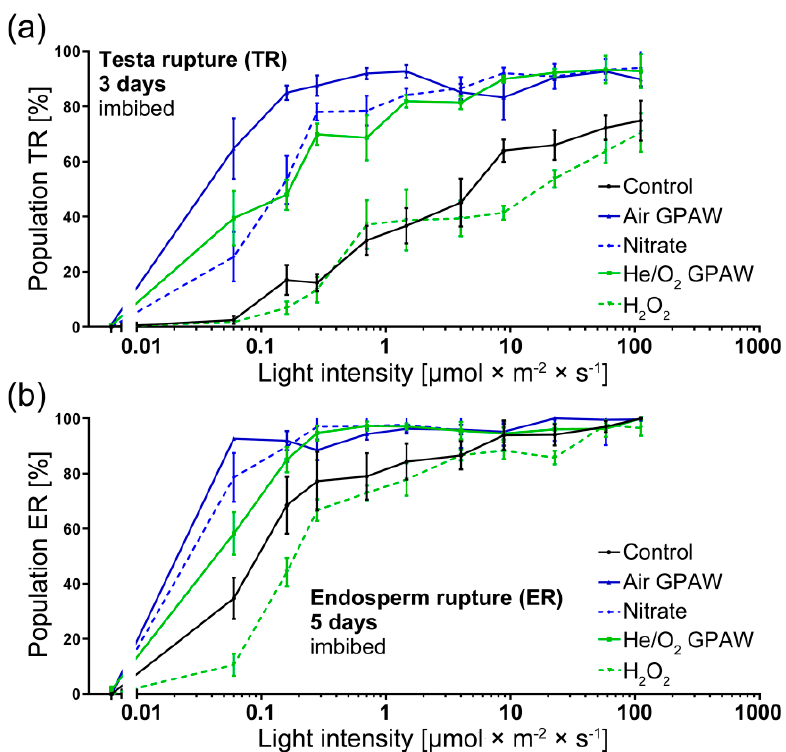
Figure 4. Nicotiana tabacum seed germination under various continuous white-light regimes with and without treatments. ( a ) TR (3 days imbibition) and ( b ) ER (5 days imbibition) percentage of dormant N. tabacum in relationship to light availability plotted on a logarithmic x axis. There were 4 treatment groups; Air GPAW, He/O 2 GPAW, Nitrate (5 mM KNO 3 − ) and H 2 O 2 (300 µM); control seeds were imbibed in water.